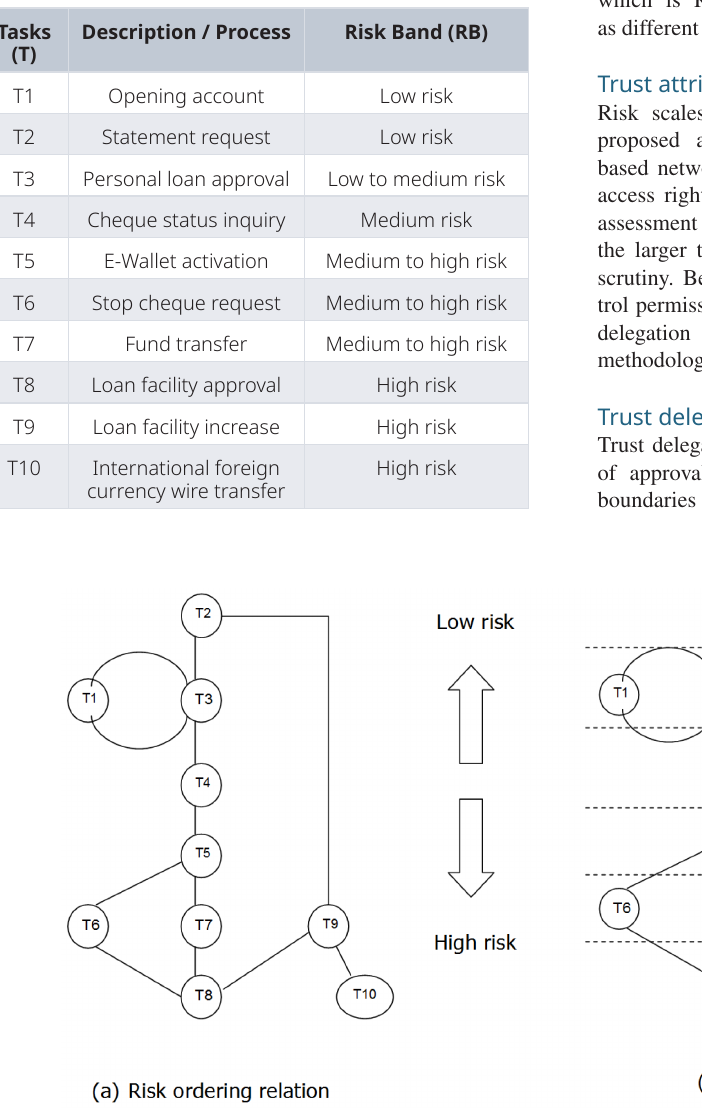
Table 2. Automated Transaction.